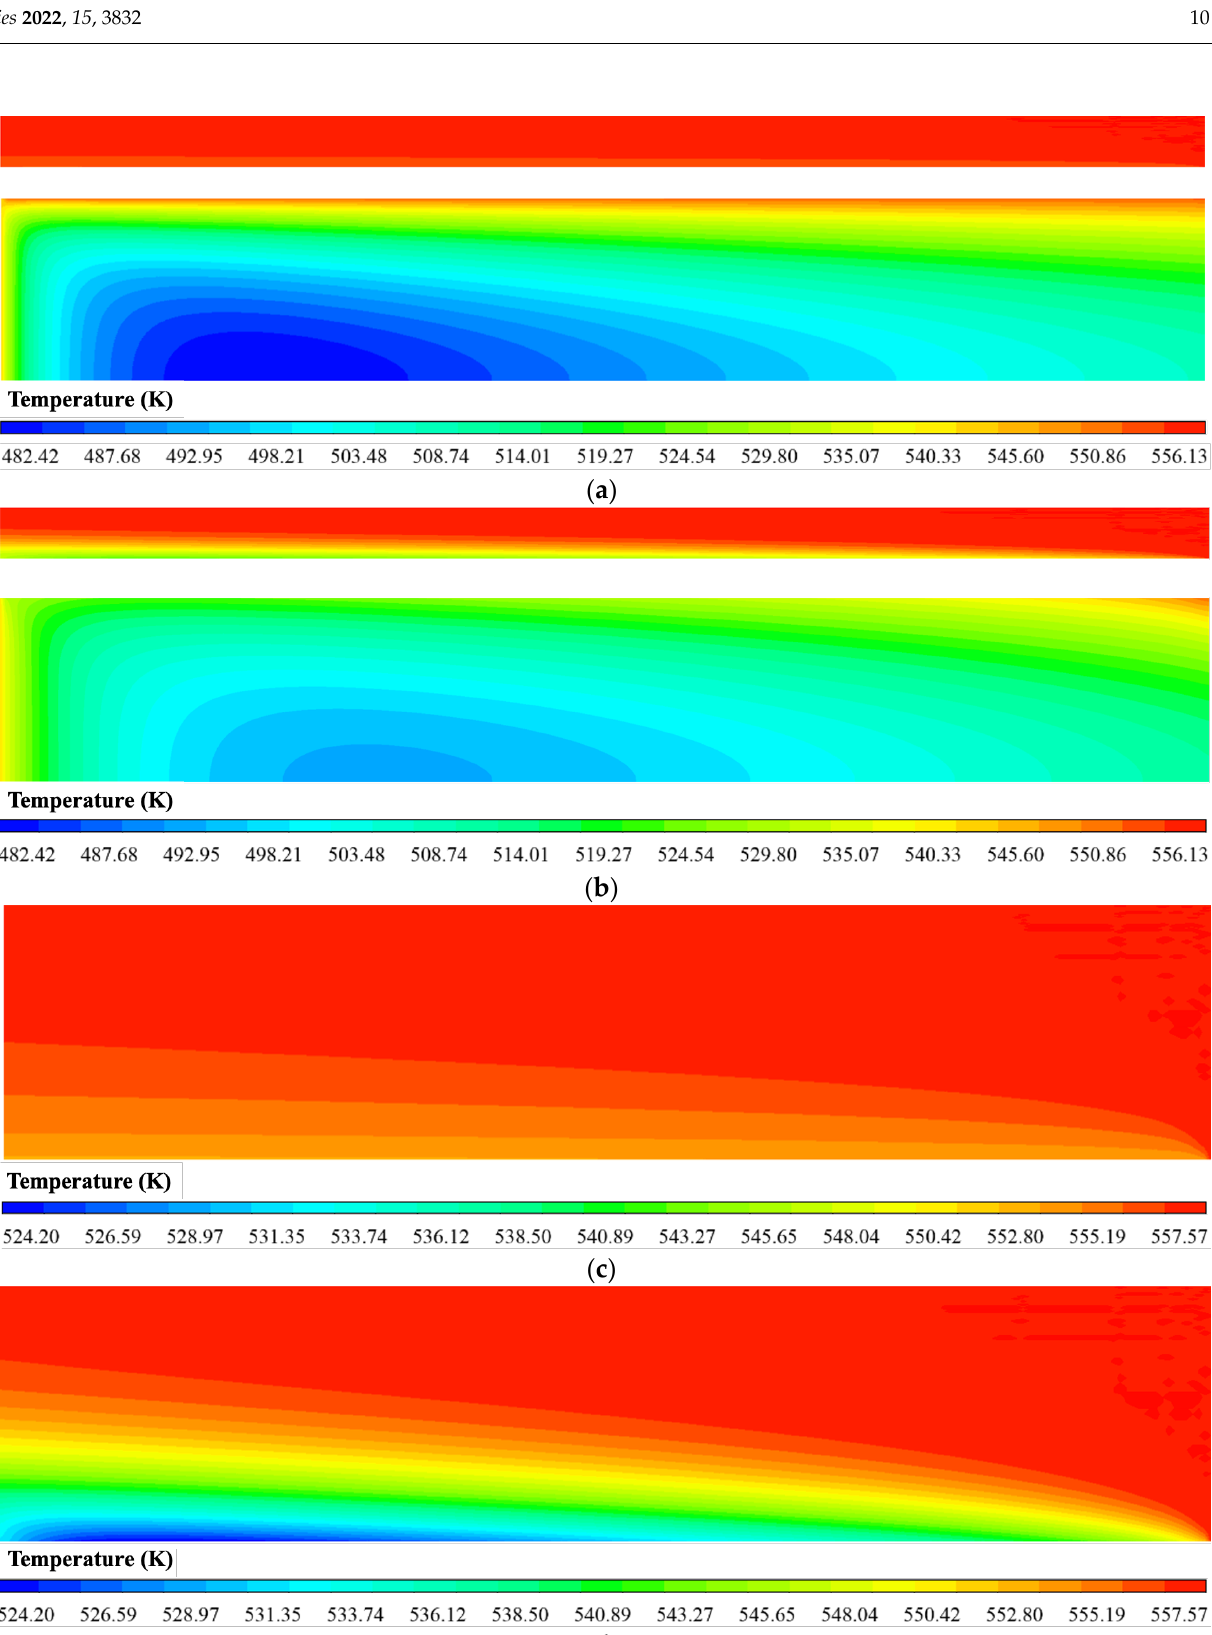
Figure 4. Temperature contours of the MSR (aspect ratio 1:10) using ( a ) steam and ( b ) air and of the outer pipe (aspect ratio 1:50) using ( c ) steam and ( d ) air. The color bar below each panel shows the temperature scale.